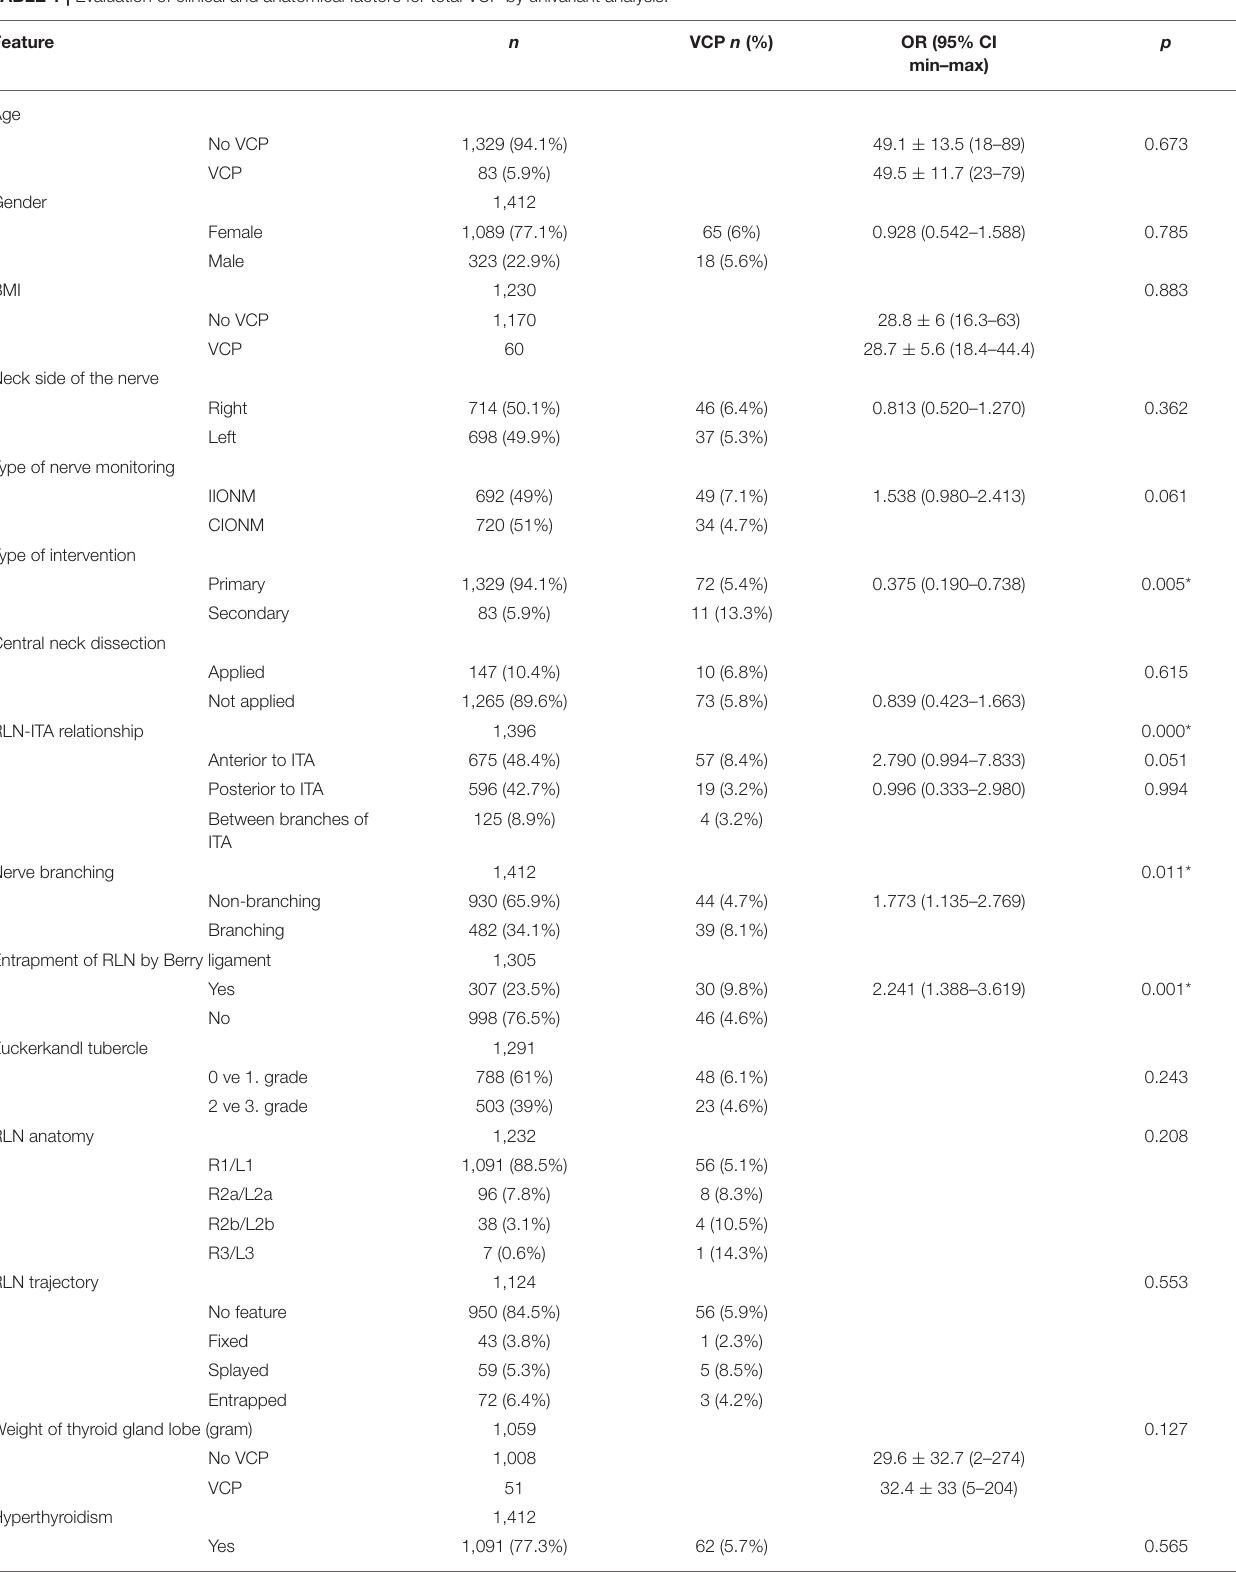
TABLE 1 | Evaluation of clinical and anatomical factors for total VCP by univariant